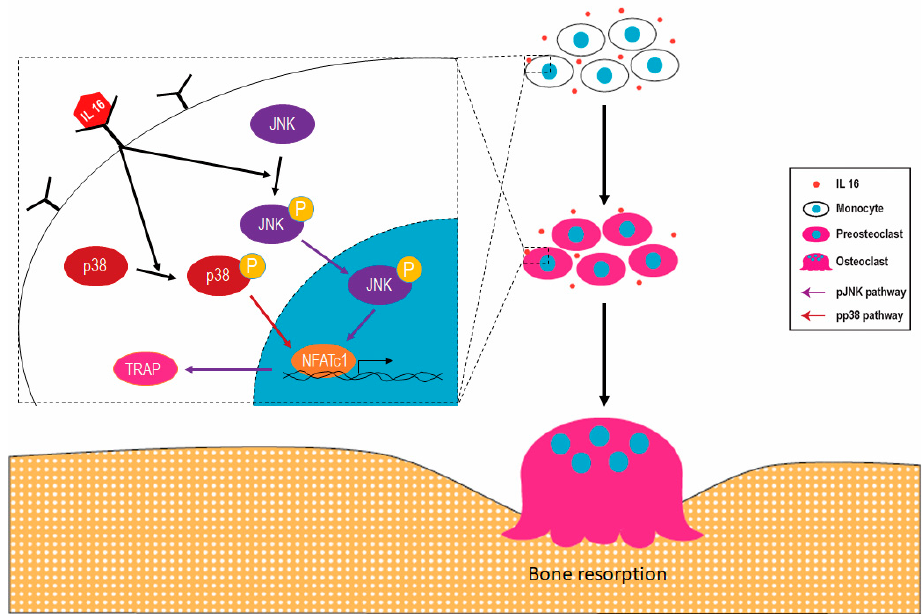
Figure 6. Interleukin-16 (IL-16) may promote osteoclast activation and bone loss in patients with periprosthetic joint infections through the c-Jun N-terminal kinases (JNK) / nuclear factor of activated T cells 1 (NFATc1) signaling cascade. IL-16 in inflammatory environments enhances p38 and JNK phosphorylation. The phosphorylation of JNK activates the downstream molecules NFATc1 and tartrate-resistant acid phosphatase (TRAP) and finally causes monocyte to di ff erentiate into osteoclasts. These overactivated osteoclasts may cause bone loss in